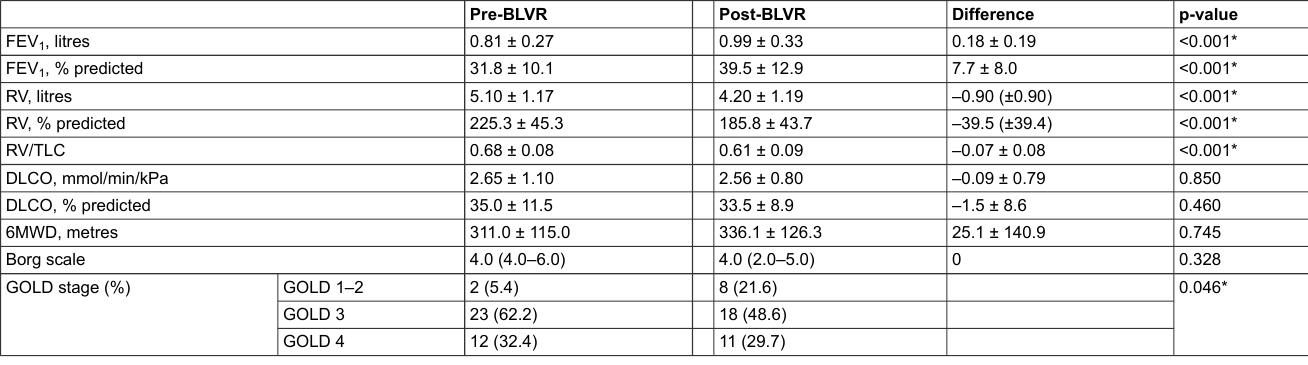
Table 3: Change in clinical effectiveness data 63.2 ± 26.8 days after bronchoscopic lung volume reduction using endobronchial valves.